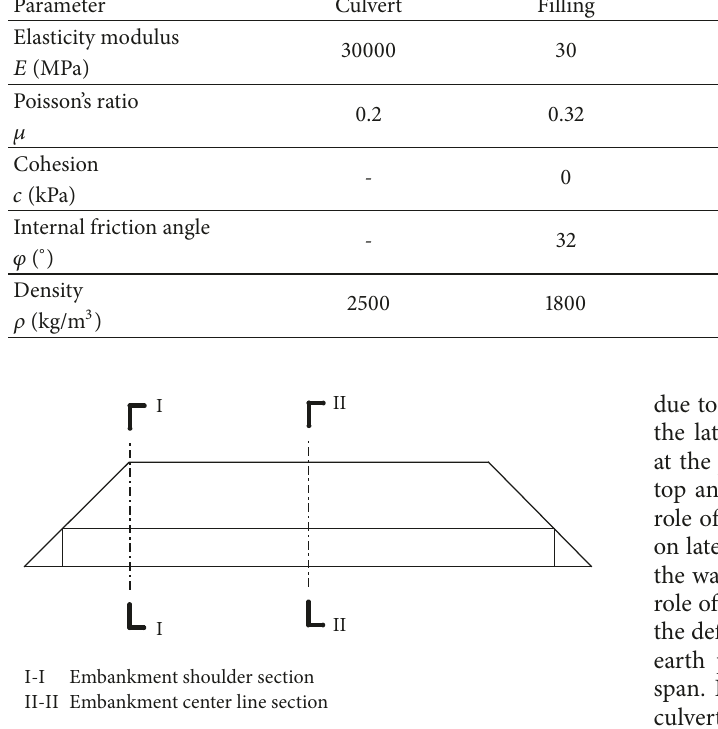
Figure 3: Sketch of the test